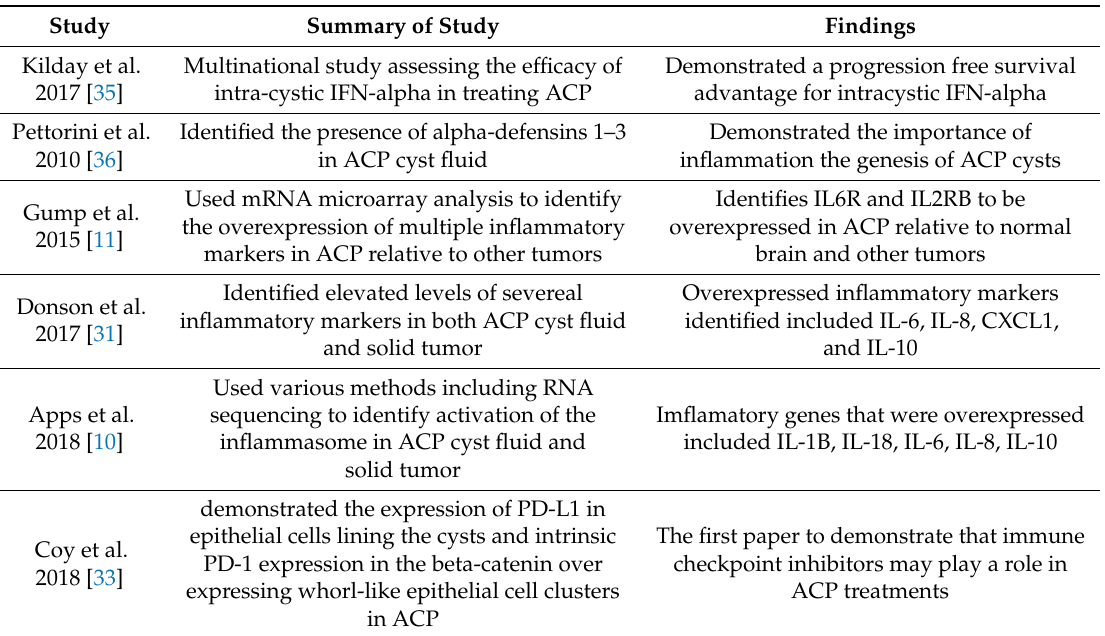
Figure 3. Example of an adamantinomatous craniopharyngioma with a massive cystic component. Table 1. Key studies that have demonstrated the key role of the inflammatory / immune response in the Table 1. Key studies that have demonstrated the key role of the inflammatory/immune response in pathogenesis of adamantinomatous the pathogenesis of adamantinomatous craniopharyngioma.